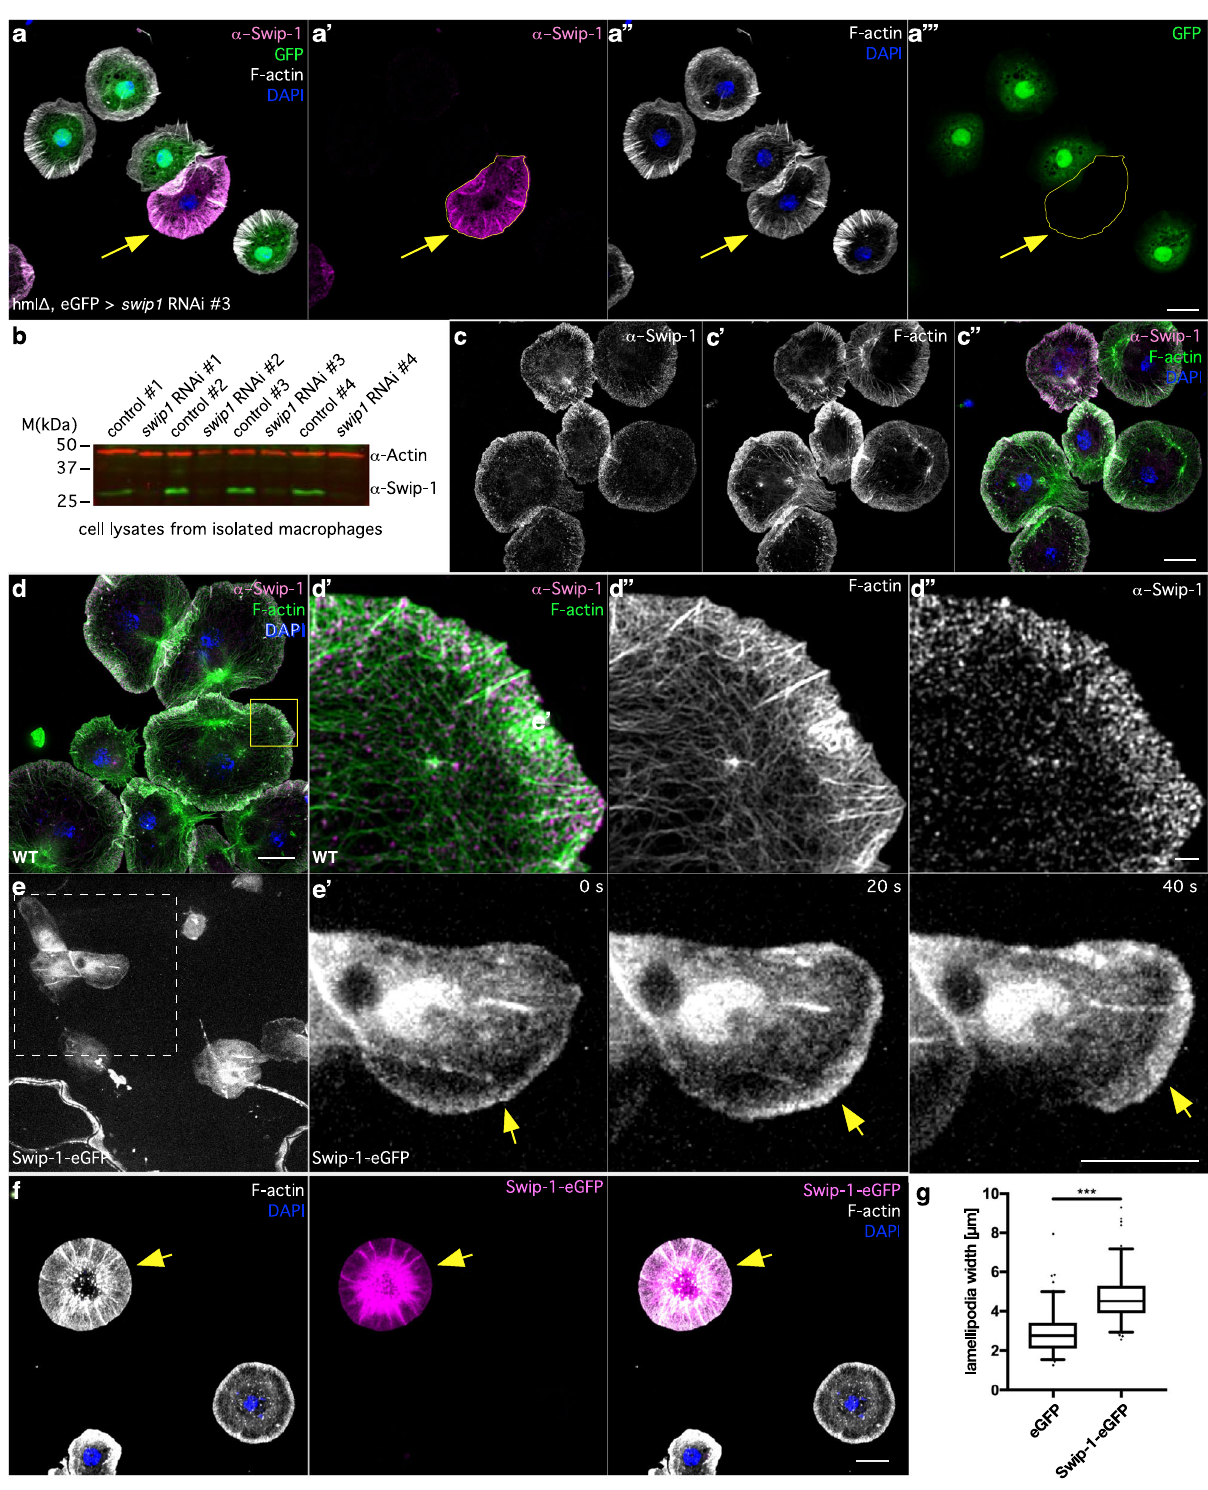
mean of 3.9 ± 0.7 µm/min (Fig. 2m and Supplementary Movie 2). The increased migration speed of mutant cells was rescued by re- expressing Swip-1 (Fig. 2k and quanti fi cation in Fig. 2m). By contrast, the overexpression of the same Swip-1 transgene in a wild-type background resulted in subtle but signi fi cant reduced migration speed (Fig. 2i and quanti fi cation in Fig. 2m). Cells overexpressing Swip-1 formed enlarged but often depolarized lamellipodia protrusions, which is expected to reduce